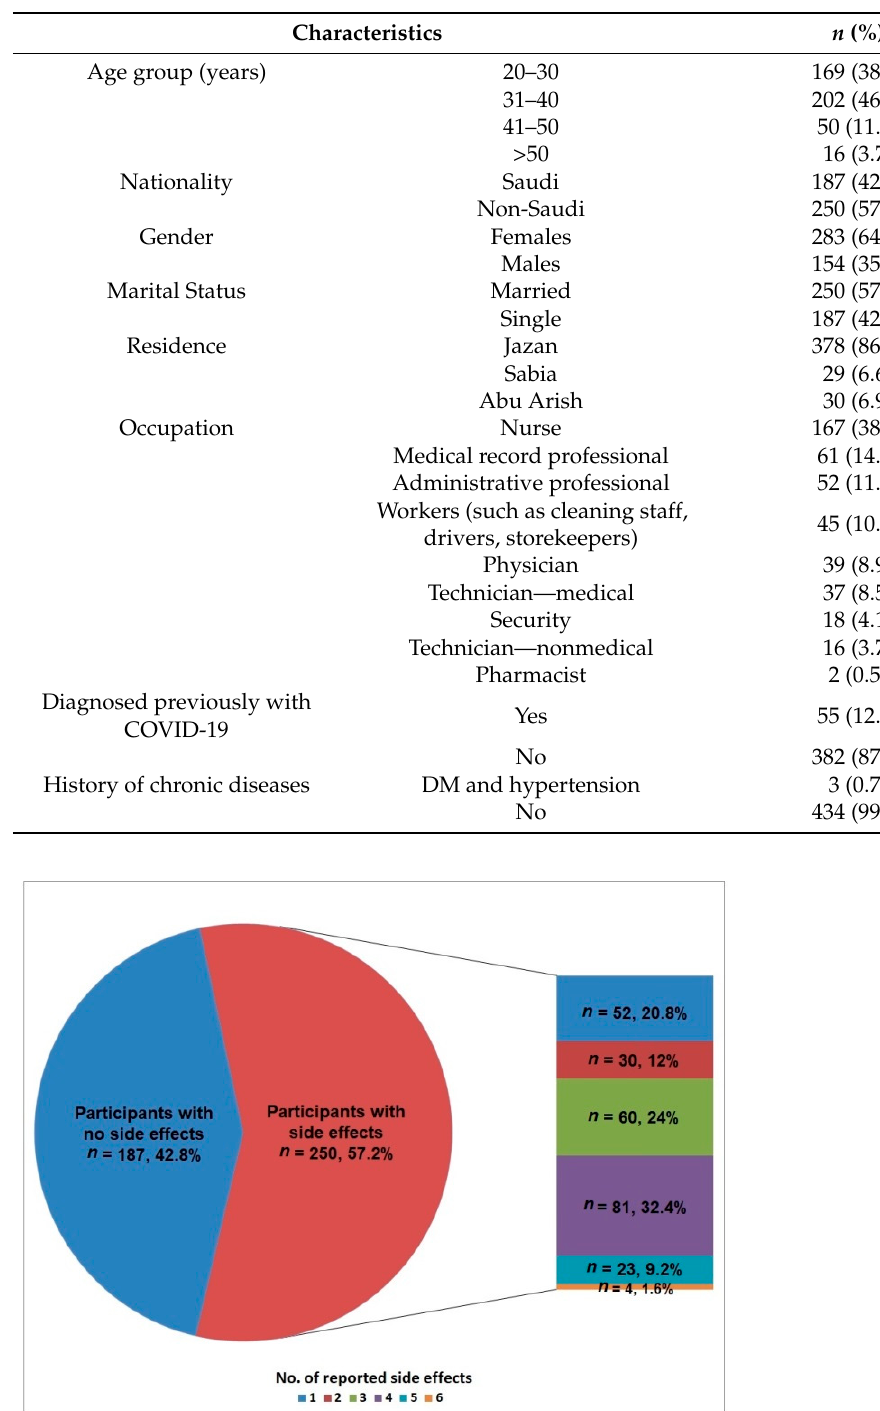
Figure 2. The frequency of COVID-19 vaccine side-effects reported among the participants ( n = 250). The distribution of different side-effects according to participants’ gender was inves- tigated among the HCWs who developed COVID-19 post-vaccination side-effects (Table 2). The results showed that female HCWs had a significantly higher frequency of side- effects of dizziness (11.9% vs. 3.3%; χ 2 = 5.236; p = 0.022) and chills (6.2% vs. 0.0%; χ 2 = 5.859; p = 0.015) compared to male HCWs. On the other hand, the male HCWs had a sig- nificantly higher frequency of whole-body pain/fatigue (67.8%, 61/90) compared to their female peers (50.0%, 80/160) ( χ 2 = 7.403; p = 0.007). Nonetheless, these significant differ- ences were not retained when the Bonferroni–Holm adjustment was applied.